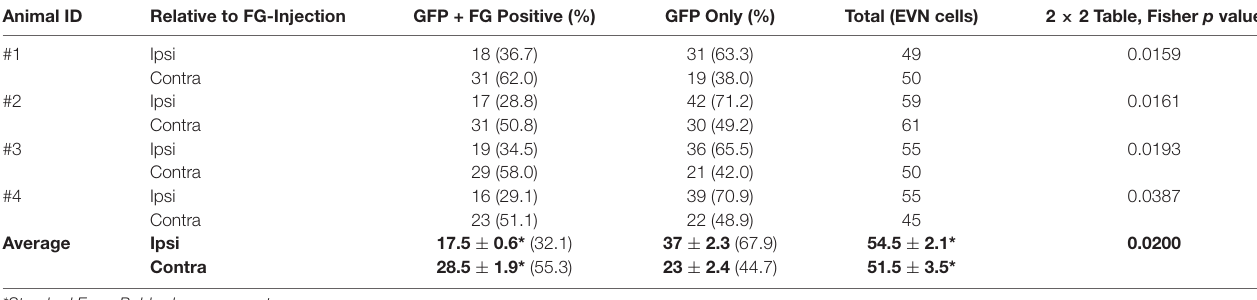
TABLE 1 | Ipsilateral and contralateral EVN neuronal cell counts of retrogradely labeled with Fluoro-Gold (FG) and expressing Green Fluorescent Proteins (GFP). Animal ID Relative to FG-Injection